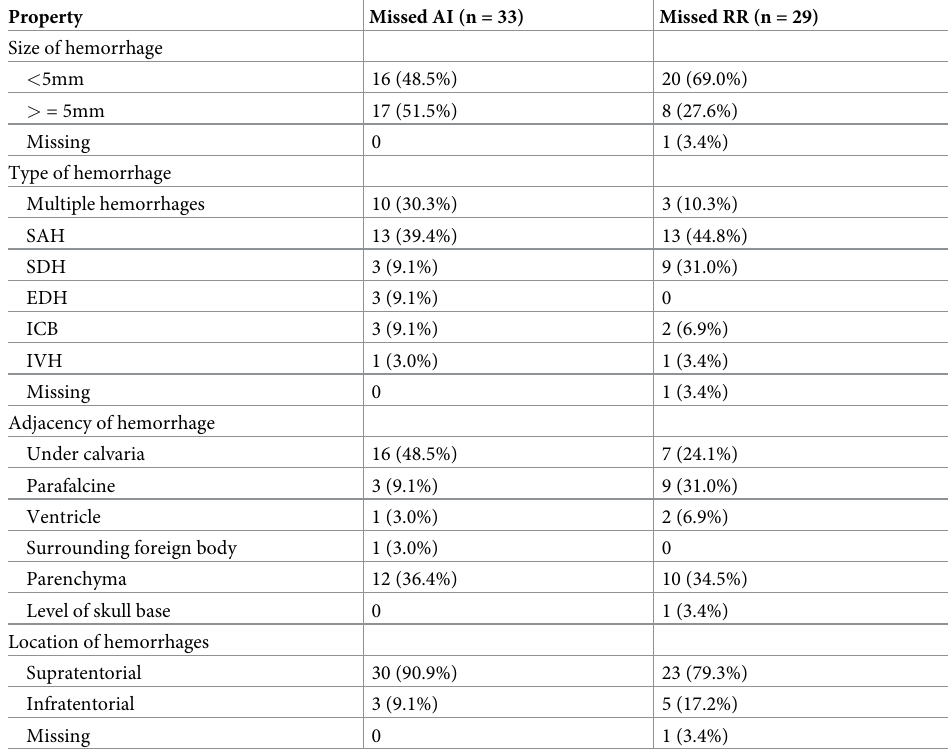
Table 2. Missed ICH by AI/RR and properties of hemorrhages.